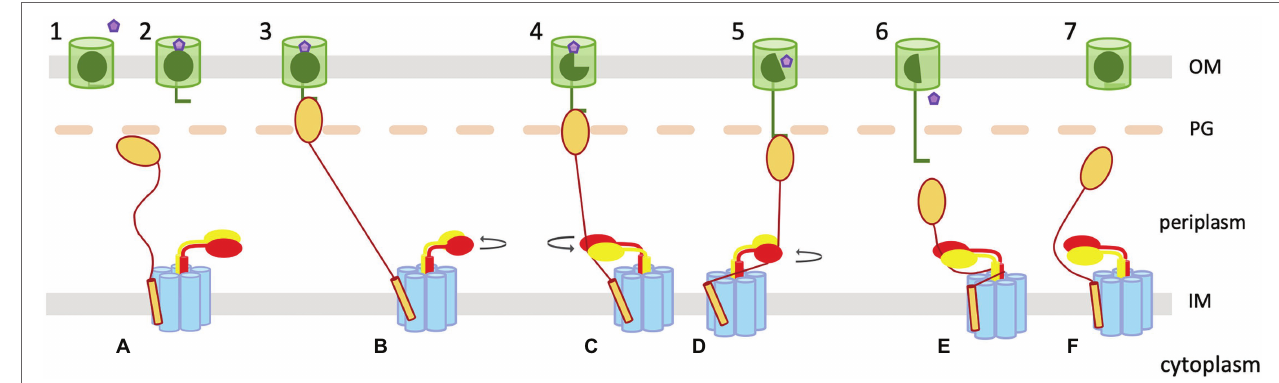
FIGURE 3 | Wrap and pull mechanistic model. The TBDT in the OM is represented with a green cylinder, with the plug domain and TonB box in dark green. The ligand to be transported is represented as a pink pentagon. TonB–ExbB–ExbD in the inner membrane are shown in gold (TonB), blue (ExbB), and red and yellow (ExbD), respectively. (1) The TBDT binds to its ligand inducing the exposure of the TonB box (2). (A) The TBD complex is in its resting state. The TonB C-terminal domain binds to the exposed TonB box of the loaded TBDT (3; B ) tethering TonB to the OM, and somehow inducing a conformational change in ExbBD that opens the proton channel, triggering the rotation of the ExbD dimer (B) . (4; C ) The rotation of ExbD leads to direct contact of ExbD with the TonB periplasmic linker and starts to pull on the C-terminal domain of TonB bound to the TBDT. (D) While the rotation of ExbD continues, the TonB linker wraps around ExbD, pulling further on the TonB–TBDT complex, partially unfolding the TBDT plug domain (5). (6) The unfolding of the plug domain reaches a point where the opening of the channel allows the ligand to diffuse to the periplasm, and the force necessary to unfold the rest of the plug is greater than the force necessary to maintain the interaction between TonB and the TonB box. TonB then dissociates from the TBDT (E) , releasing the tension on the TonB periplasmic linker and reverting the ExbBD complex to the closed state. (7) The plug domain folds back into the TBDT barrel; and (F) the TBD complex goes back to its resting